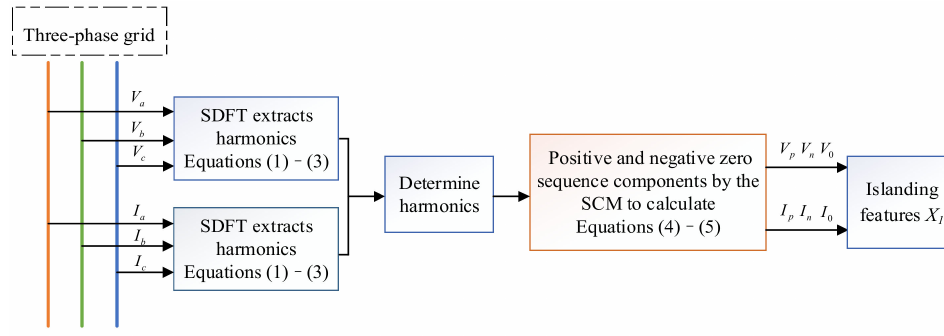
Figure 2. Schematic diagram of SDFT-SCM feature extraction. Analysis of the Islanding Features Index by SDFT-SCM